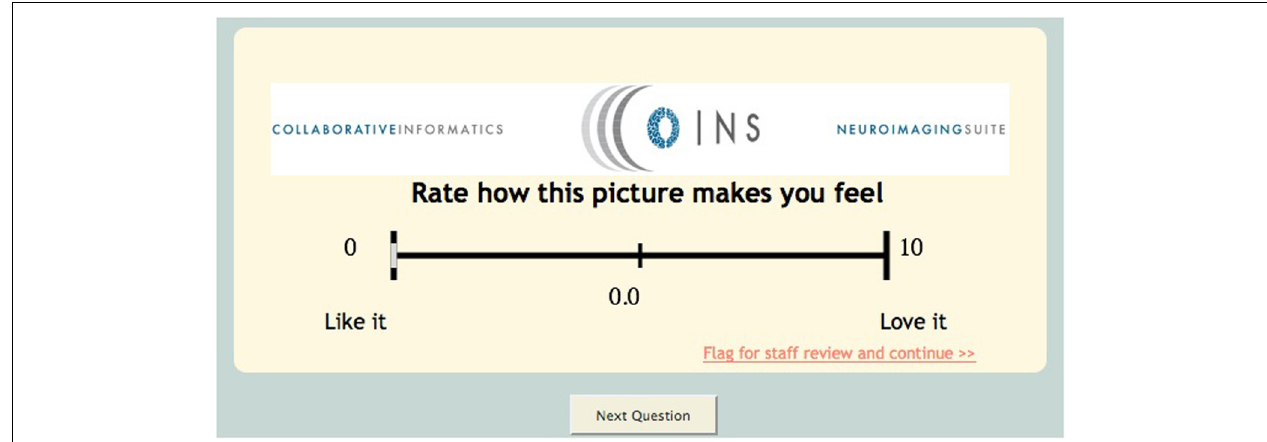
FIGURE 4 | Visual analog